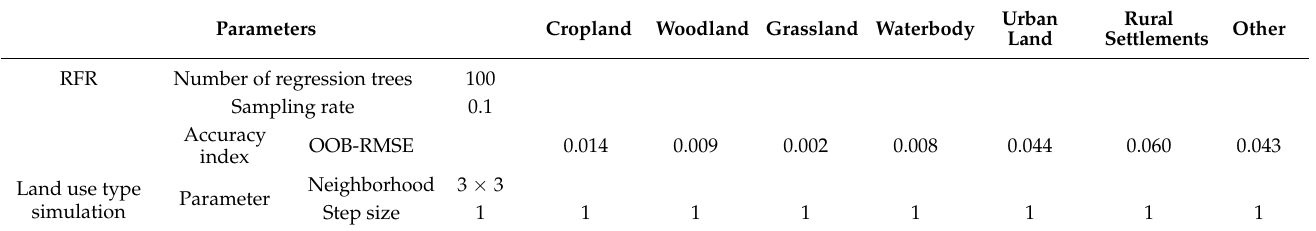
Figure 3. Driving factors for the rural settlement simulation. Table 2. Parameter settings of the MCCA model.